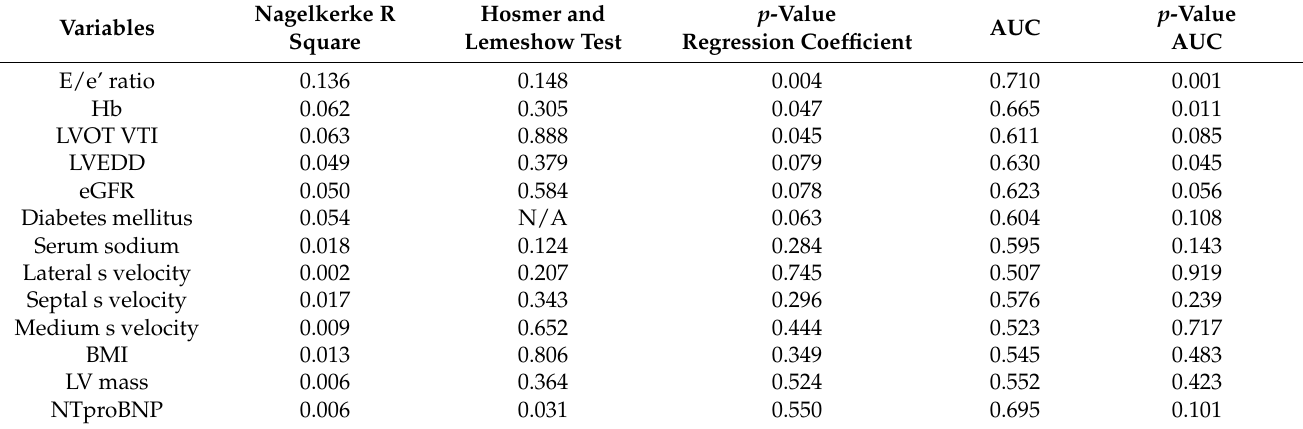
Table 3. Selection of the independent variables by bivariate linear regression/univariate